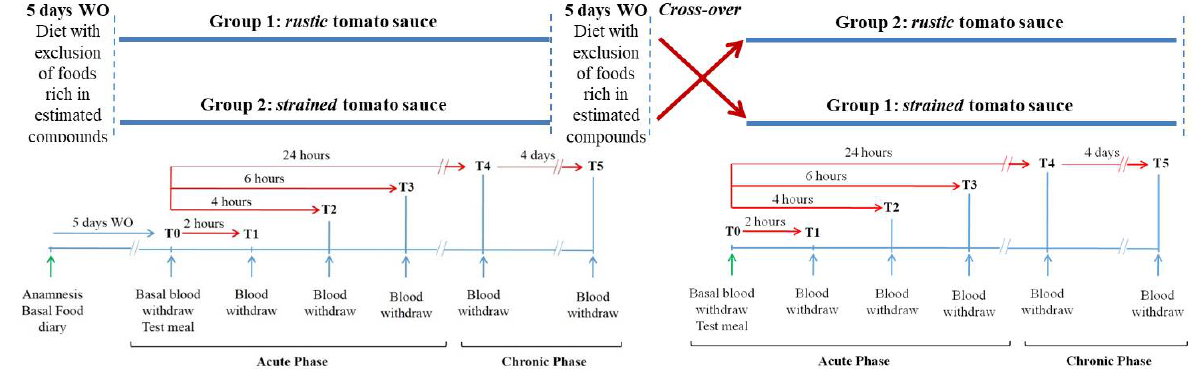
Figure 1. Experimental plan shows a randomized cross-over design. Five days of washout (WO) precede baseline blood withdrawal (T0); blood samples collected at 2, 4, 6, and 24 h (T1, T2, T3 and T4) following test meal consumption; blood withdrawal after four more days of chronic consumption of tomato sauce (T5). Strained tomato sauce and rustic tomato sauce are sauces prepared with tomato purèe + dressing + 30 min boiling (see details under Methods section).